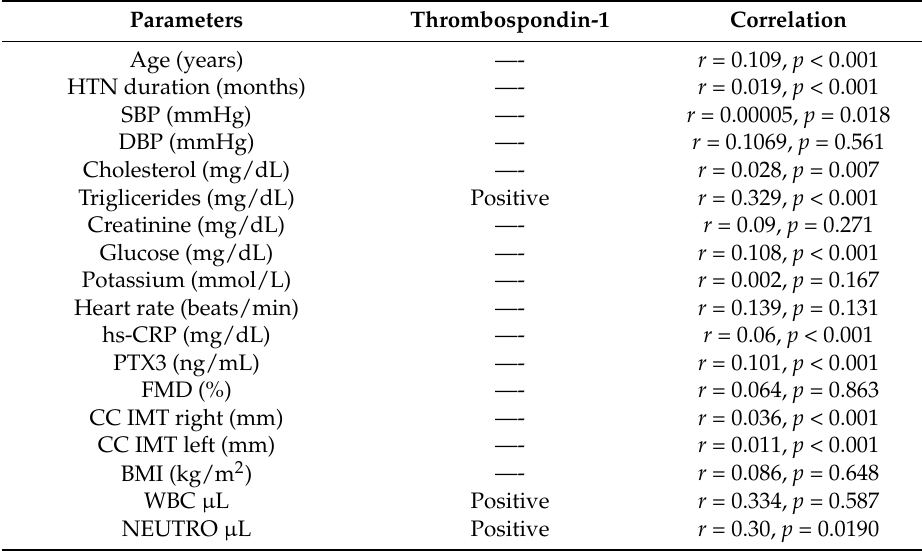
Table 6. Correlation of TSP-1 plasma levels with all data in Group B.